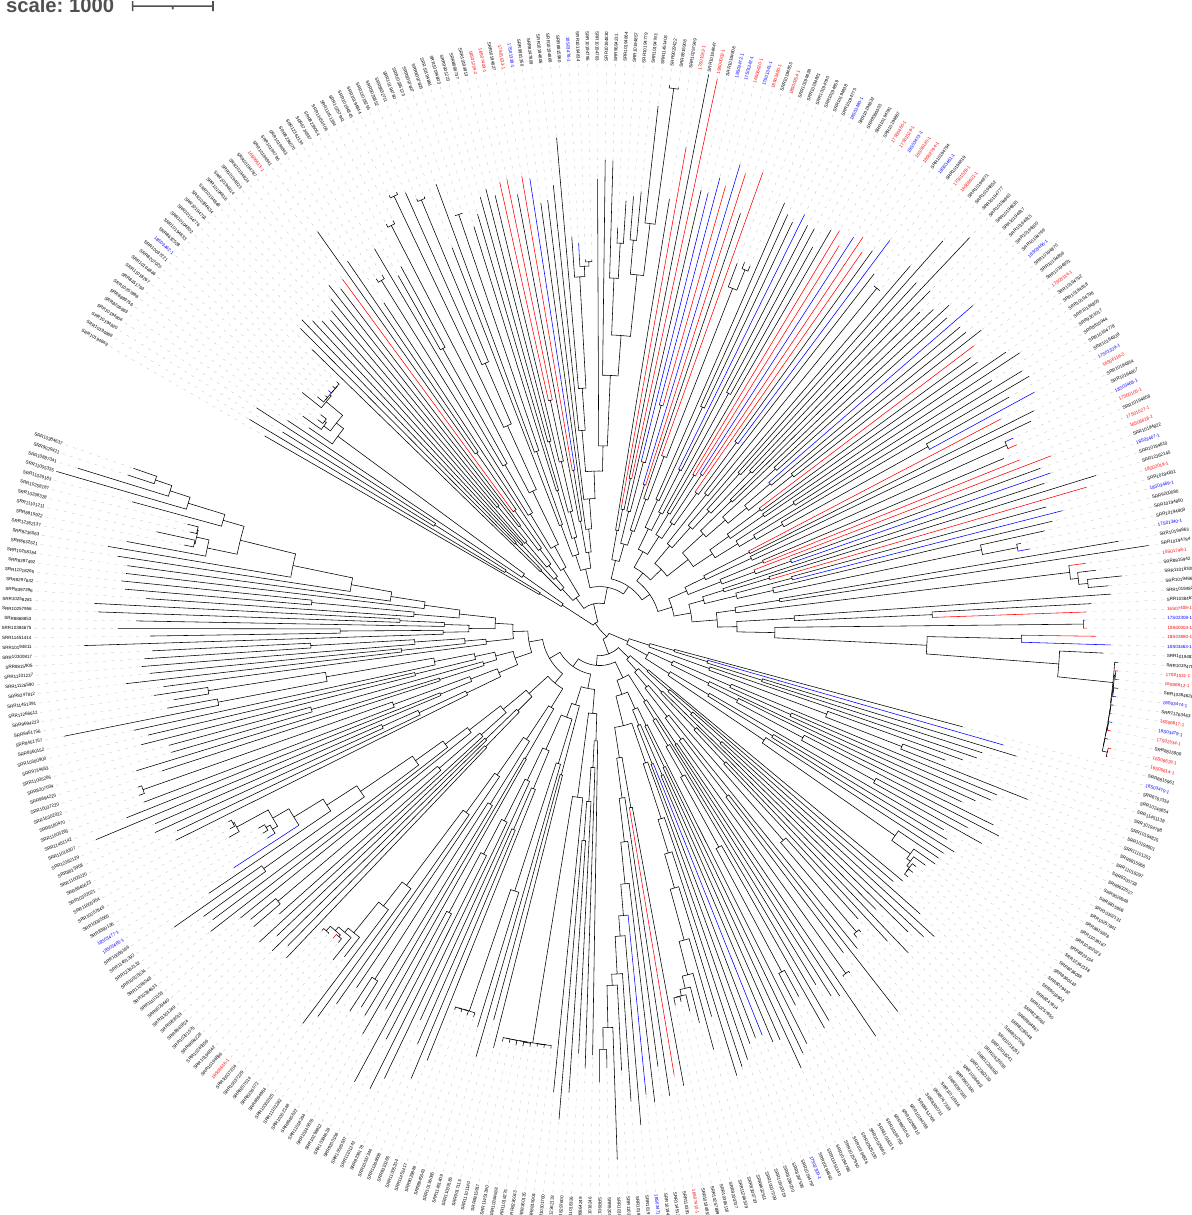
Figure 1. Phylogenetic tree based on the core genome SNPs of MSSP isolates. Publicly available MSSP genomes were compared with the MSSP isolates from this study, that have been marked red for human isolates and blue for dog isolates